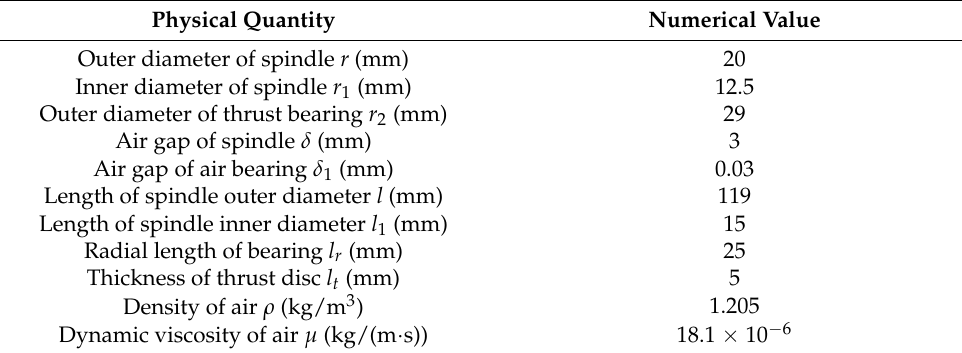
Figure 2. Simplified model sectional view of air compressor. Table 1. Calculation